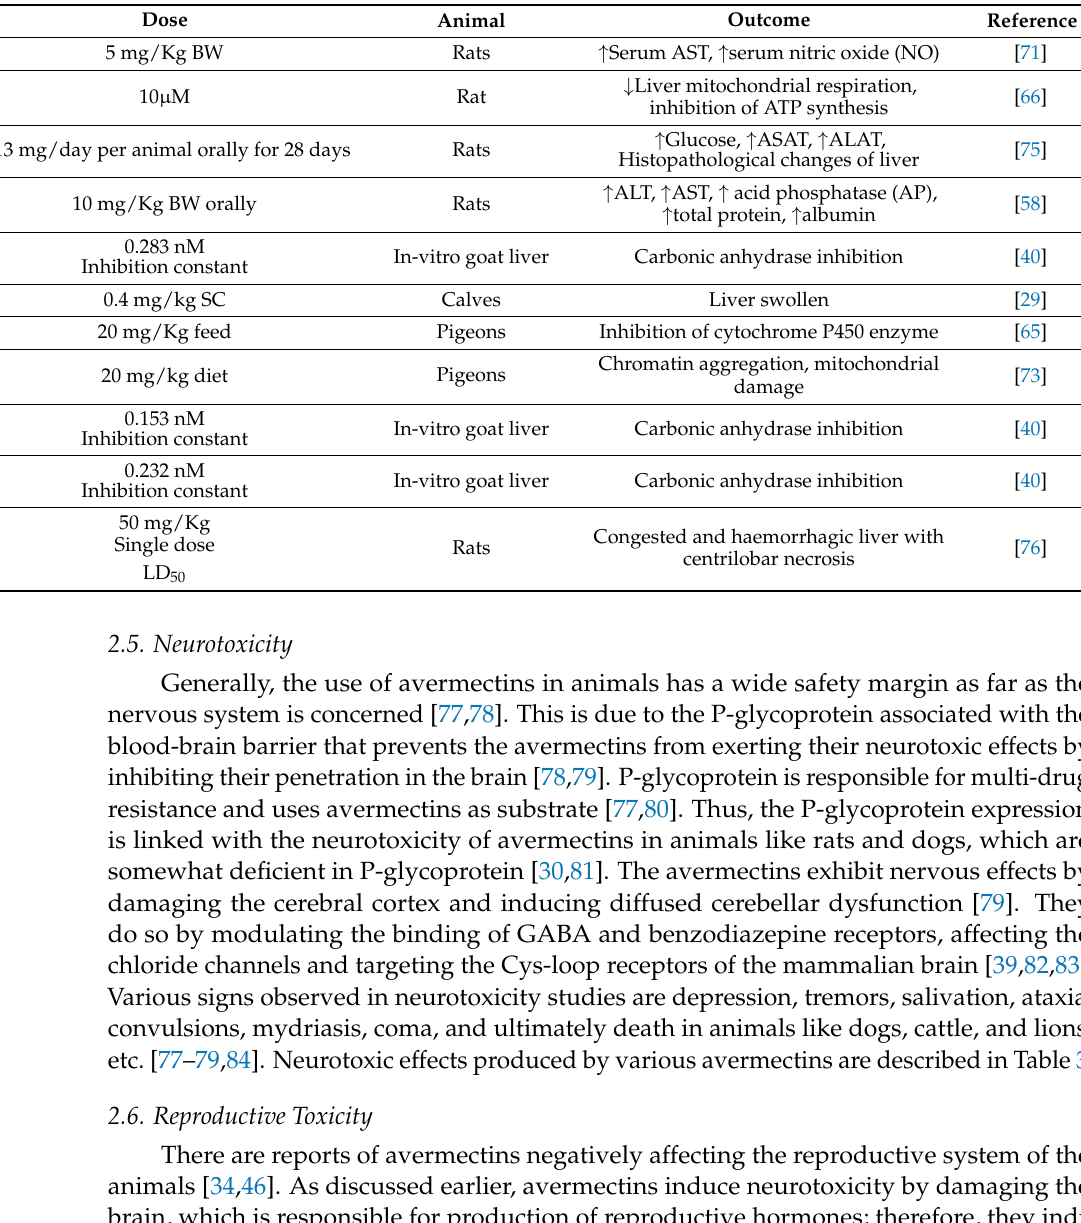
Table 2. Hepatotoxic avermectins along with dose, animal, and